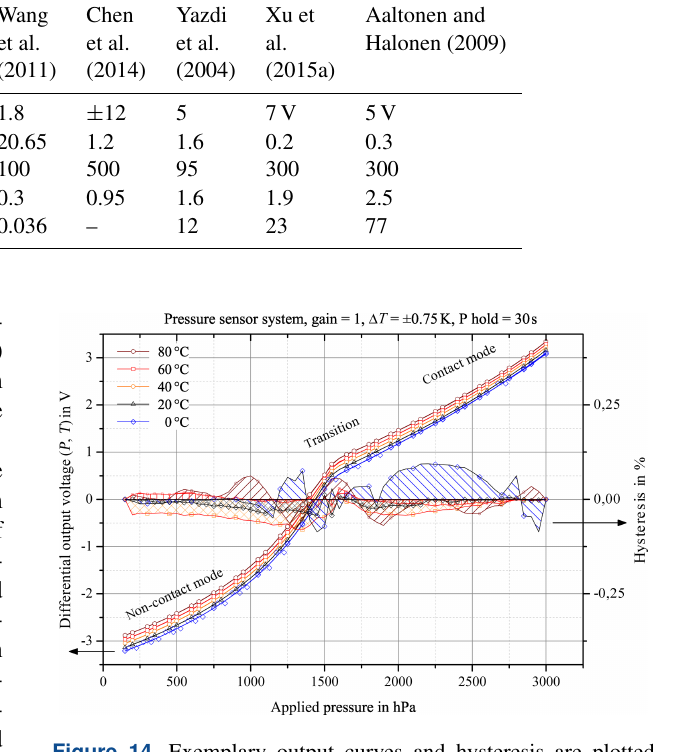
Figure 14. Exemplary output curves and hysteresis are plotted against applied pressure within a temperature span of 0 to 80 ◦ C, within a full scale range of the applied pressure of 150 to